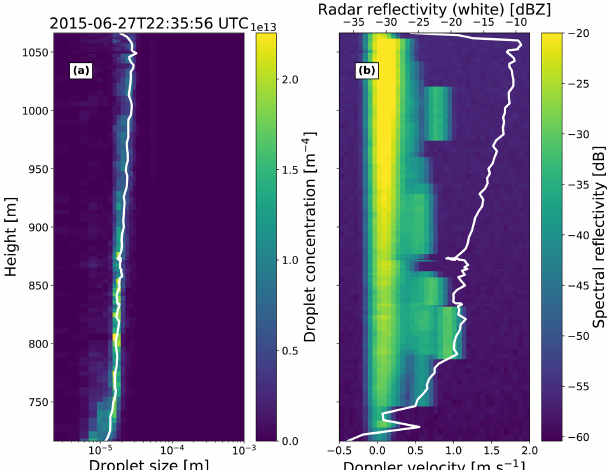
Figure 6. (a) Observed drop size distribution and (b) forward- modeled radar Doppler spectrum of the sample cloud in the ACME- V campaign. The white line denotes (a) the effective diameter and (b) the radar reflectivity Z e